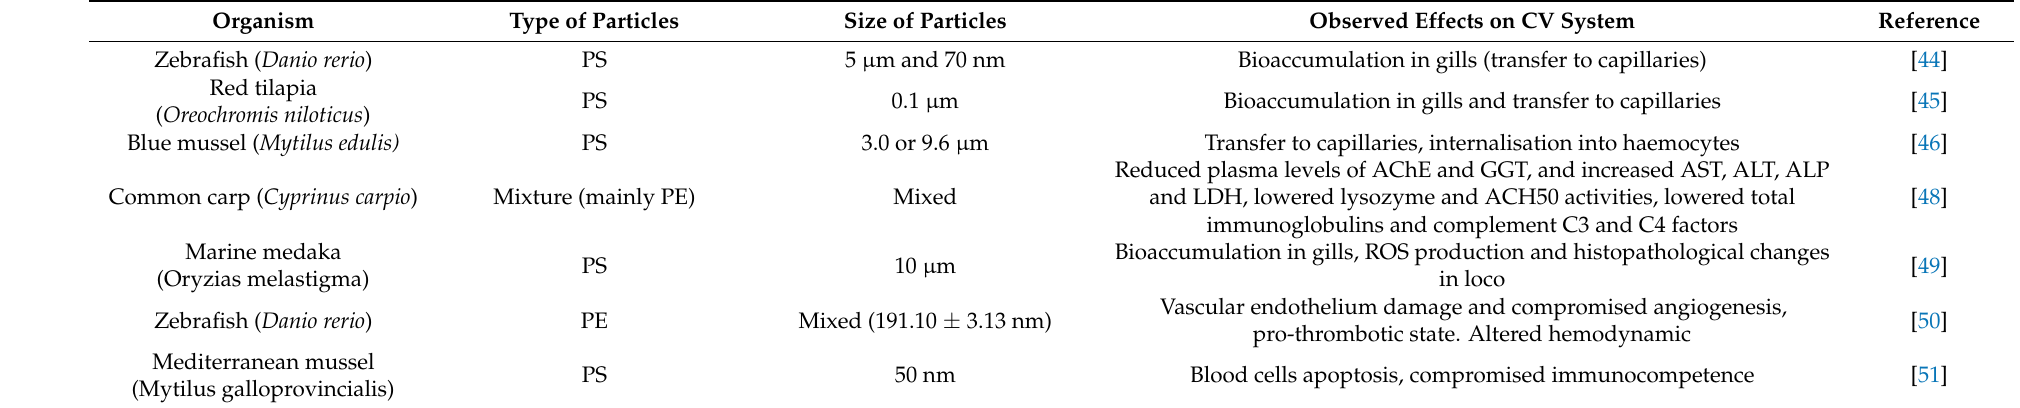
Table 1. Summary of the main features of MPs/NPs in studies on the cardiovascular (CV) system of aquatic organisms included in the present review. PS: polystyrene; PE: polyethylene; AChE: acetylcholinesterase; GGT: gamma glutamyl-transferase; AST: aspartate aminotransferase; ALT: alanine aminotransferase; ALP: alkaline